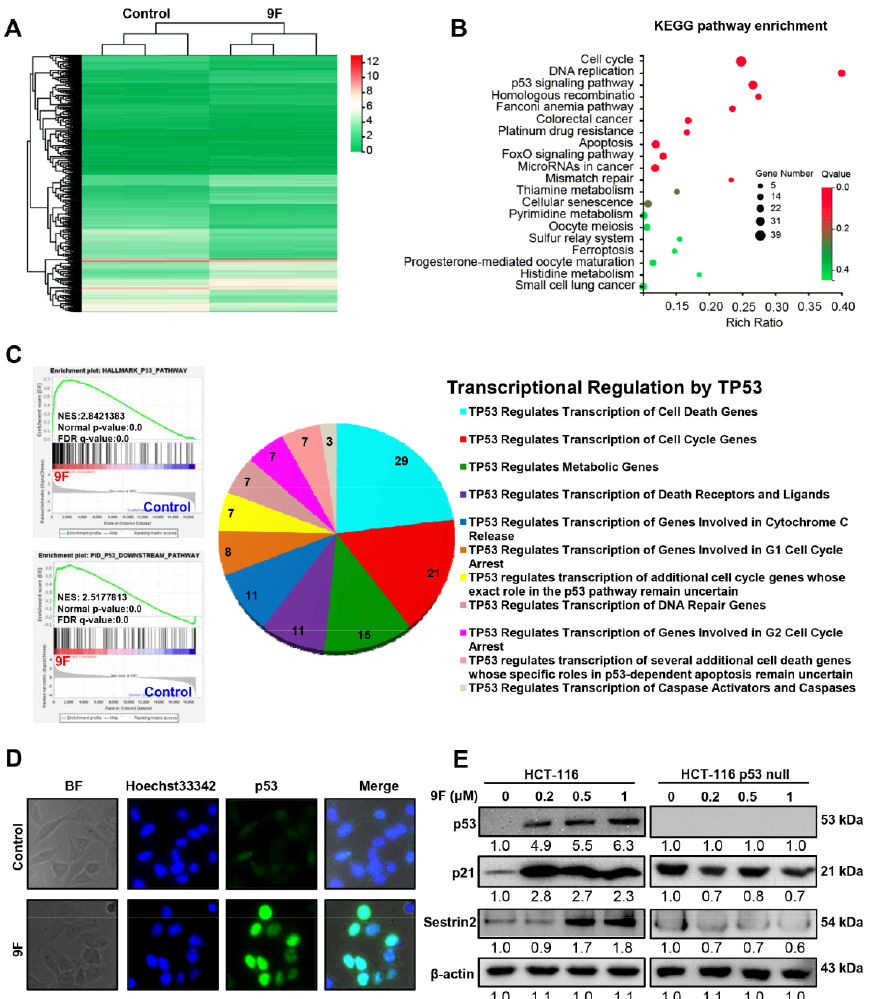
Figure 2. p53 signaling was altered in 9F-treated CRC cells. ( A ) Cluster heatmap of differentially expressed genes in 9F-treated HCT116 cells. Cells were treated by 9F (1 μM) for 24 h. ( B ) KEGG pathway enrichment analysis of differentially expressed genes (DEGs) were performed. The top20